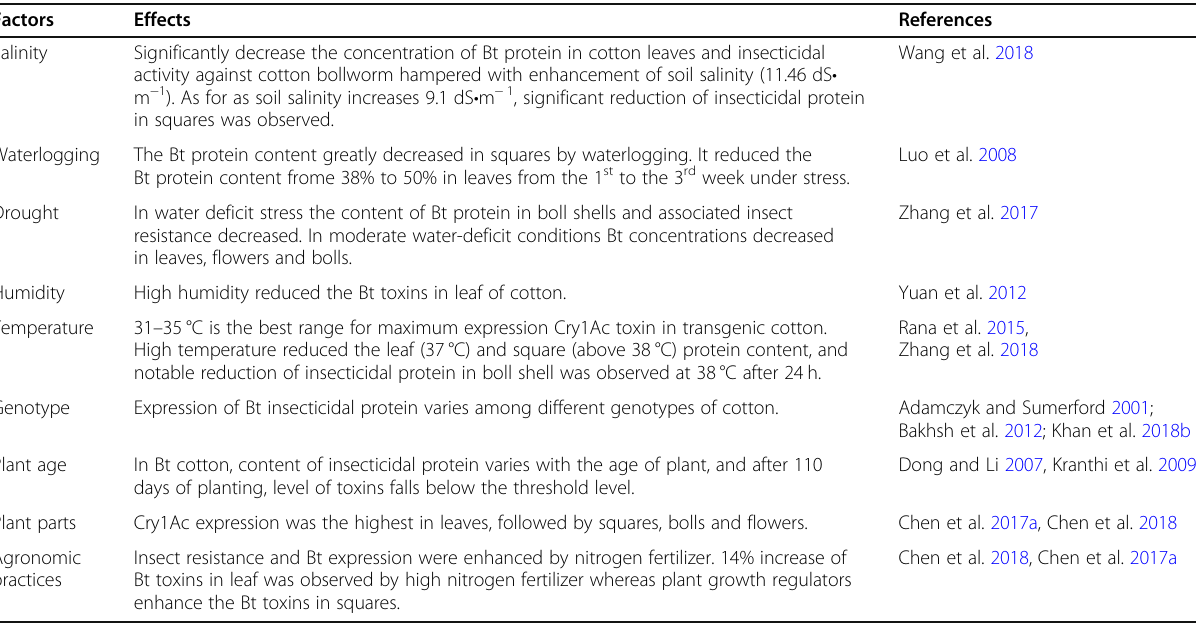
Table 1 Factors reducing the Bt concentration in